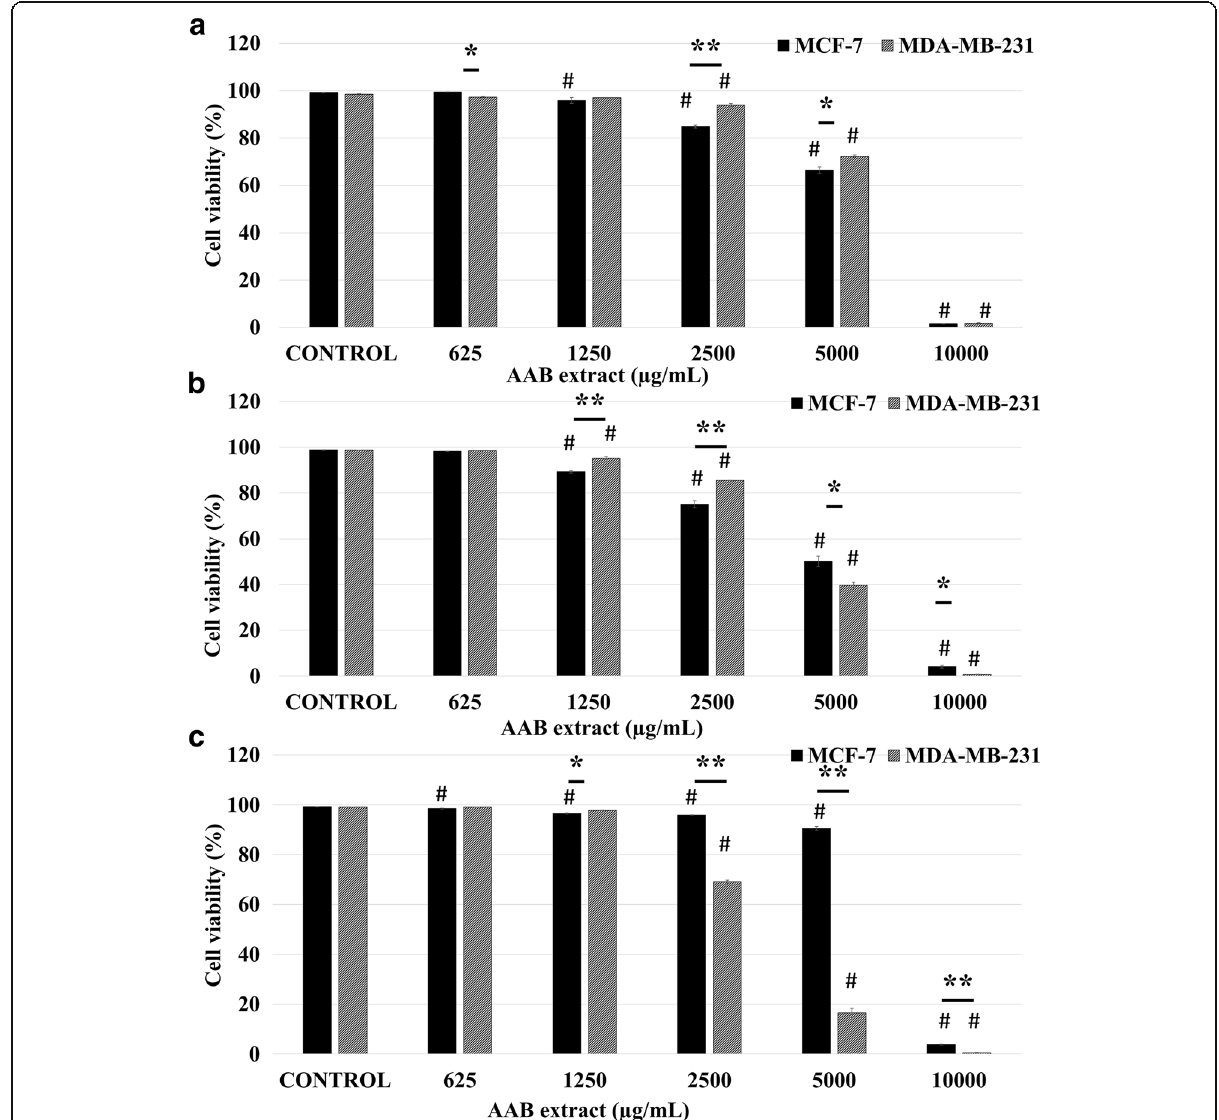
Fig. 3 AAB extract significantly reduces viability of MCF-7 and MDA-MB-231cells. The % viability of breast cancer cells was determined by viability assay for 24 h ( a ), 48 h ( b ) and 72 h ( c ). Data represents mean ± S.E.M. of six independent experiments. Statistical significance: #, p < 0.05 vs control according to ANOVA followed by Newman-Keuls post hoc analysis. p < 0.05 and **, p < 0.01 MCF-7 vs MDA-MB-231 according to Student ’ s t-